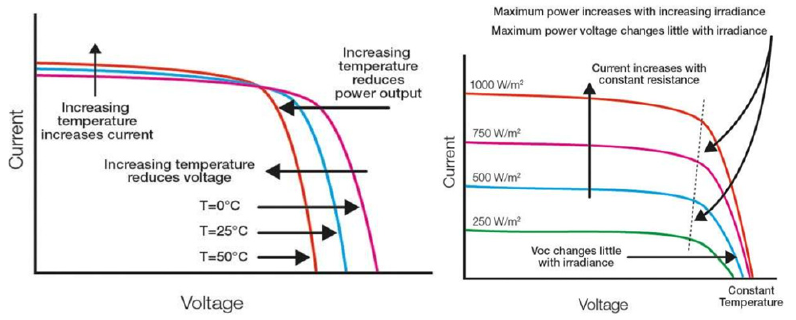
Figure 11. Typical VI characteristics of PV panel.